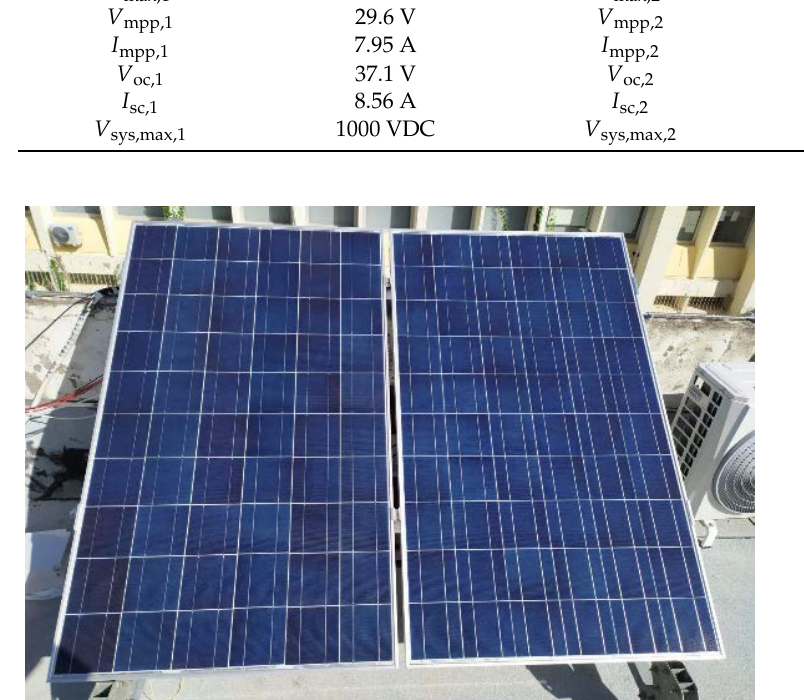
Figure 10. Photovoltaic panels PV 1 and PV 2 used for the experiments.